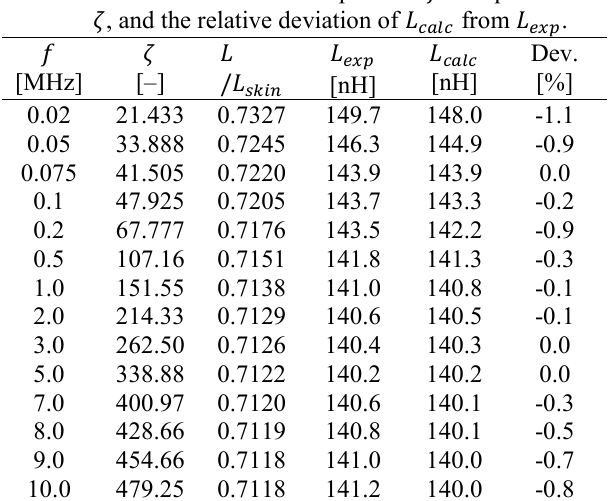
Table 4: The ratio 𝐿/𝐿 𝑠𝑘𝑖𝑛 by equation (11) of a two-wire transmission line at 𝜅 = 2.788 , the measured ( 𝐿 𝑒𝑥𝑝 ) and analytically approximated ( 𝐿 𝑐𝑎𝑙𝑐 ) in- ductance at various frequencies 𝑓 and parameters 𝜁 , and the relative deviation of 𝐿 𝐿 𝑐𝑎𝑙𝑐 from 𝑒𝑥𝑝 .